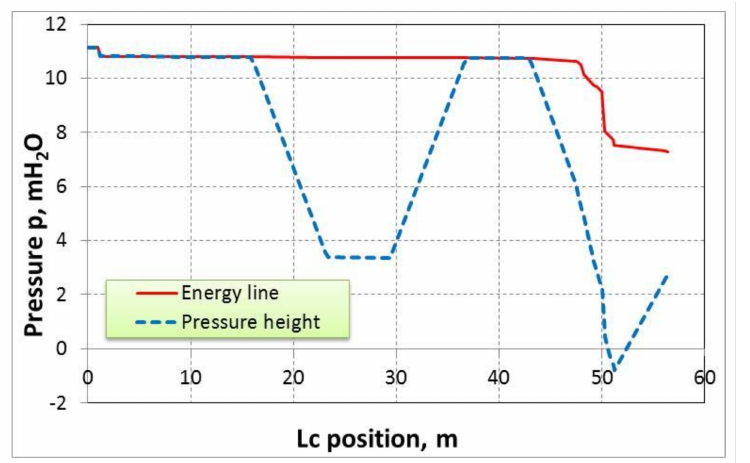
Figure 4. The energy line and the pressure height for the sulfuric acid flow through the installation with the 49% control valve opening